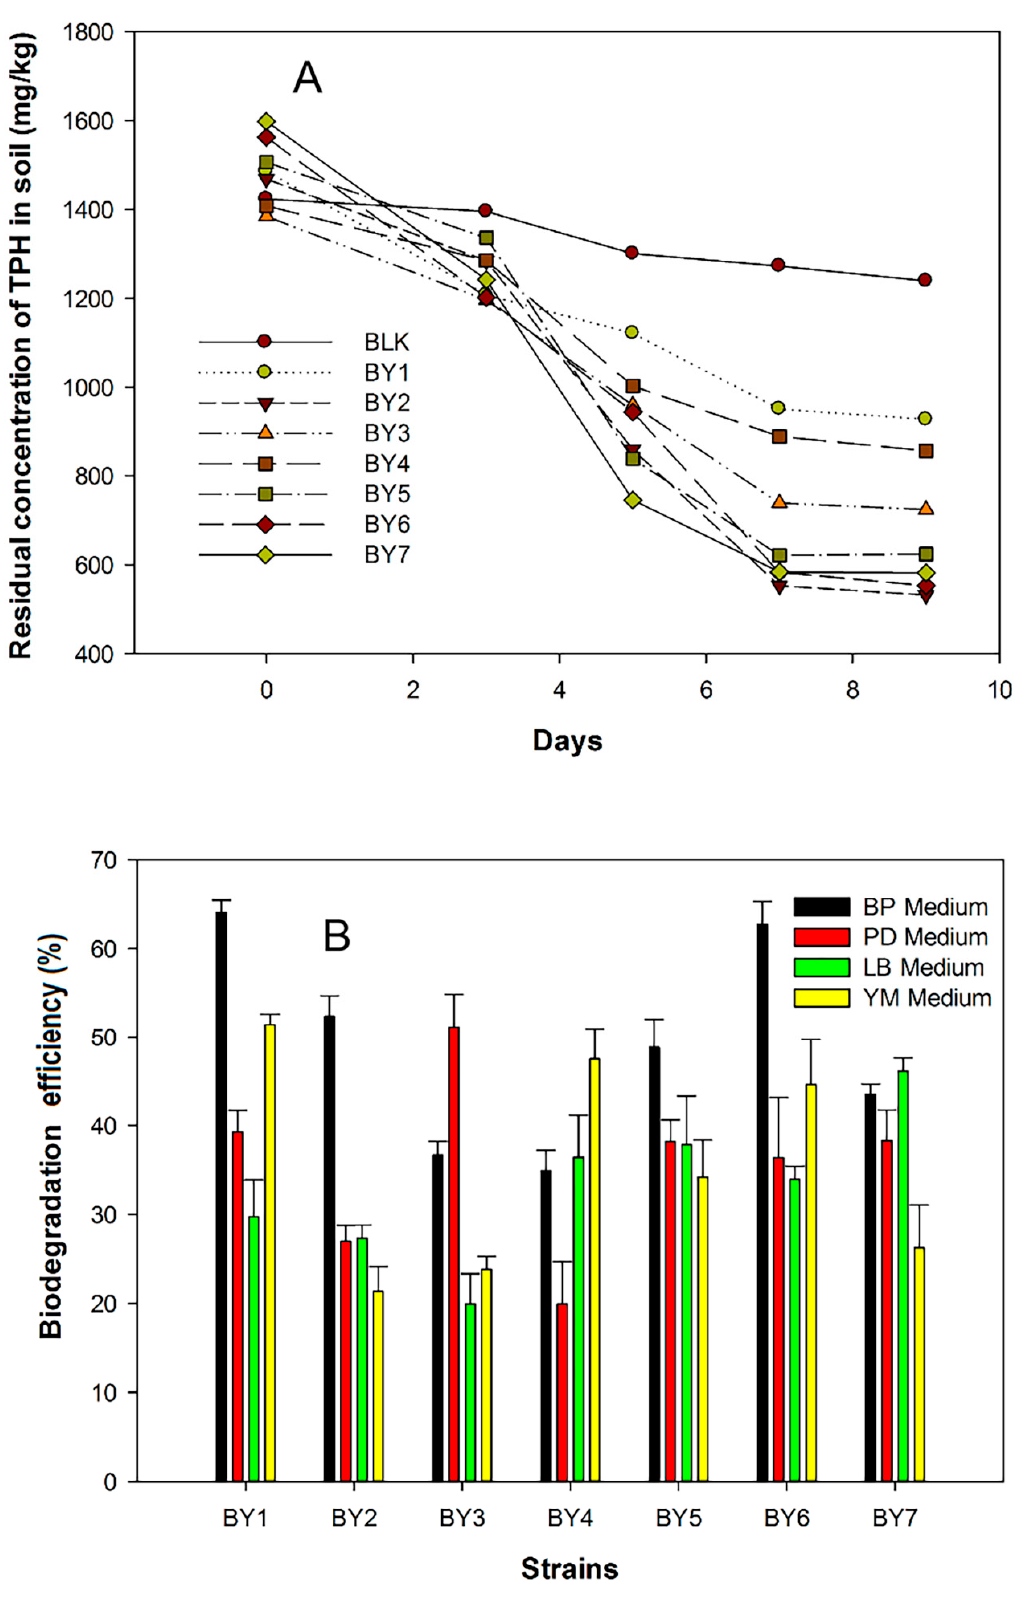
Figure 4. Residual concentration of TPH in soils using the isolated strains ( A ) and biodegradation efficiency in different growth media ( B ).